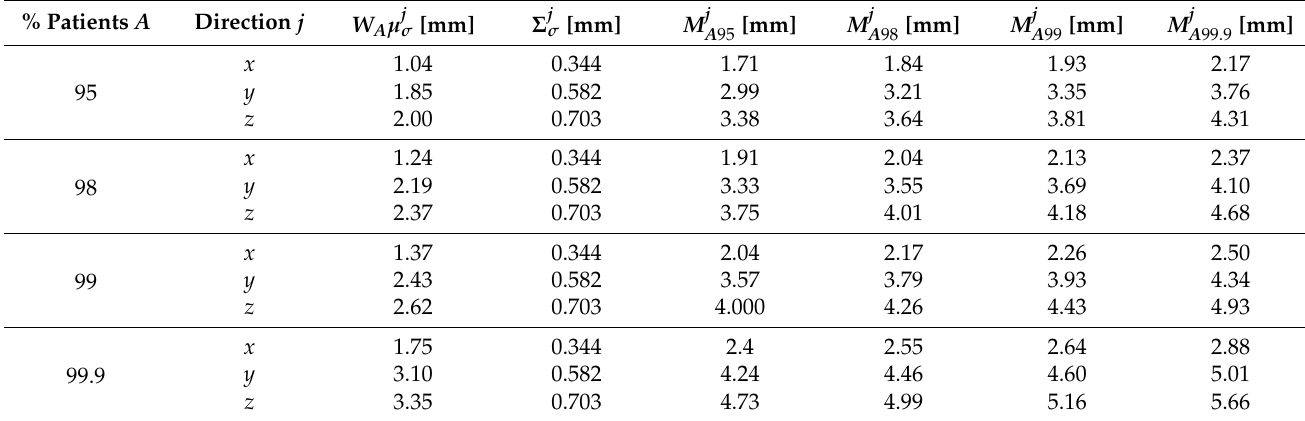
Table 6. Safety margins using the time length intervals I = 200 s.